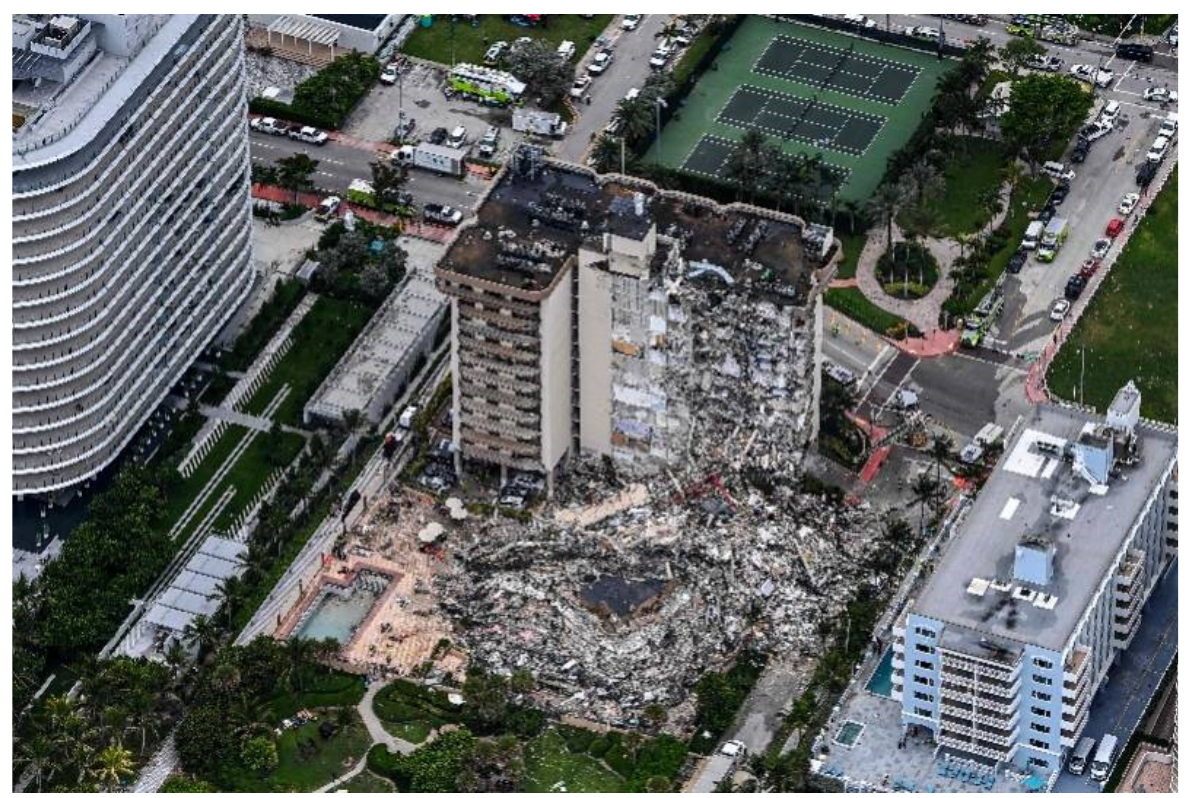
Figure 1. Collapsed condominium building (photo via Agence France-Presse) [11].